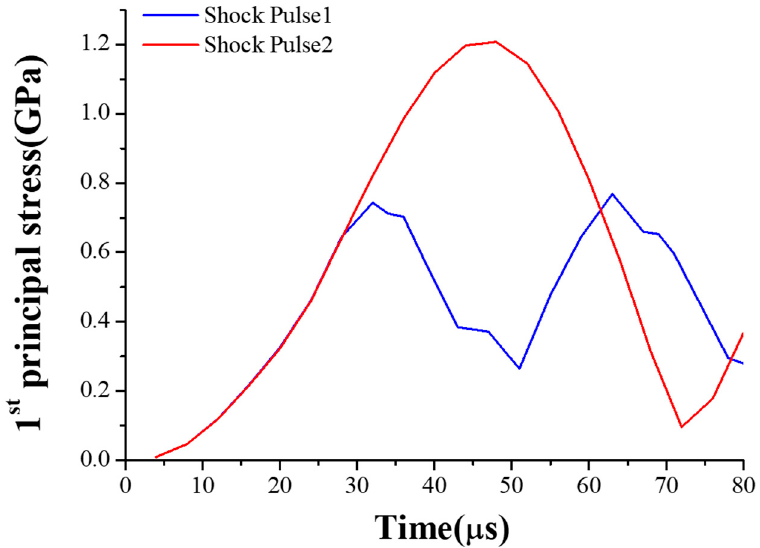
Figure 6. The Z-axis shock pulses of four different durations and directions applied in the simulation.